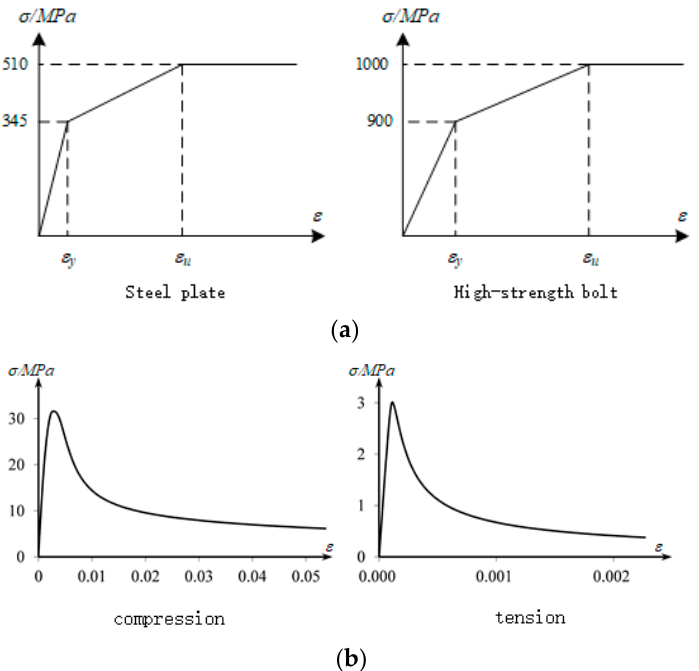
Figure 7. Stress-strain curves of steel and concrete. ( a ) Stress-strain curves of steel. ( b ) Stress-strain curves of concrete.